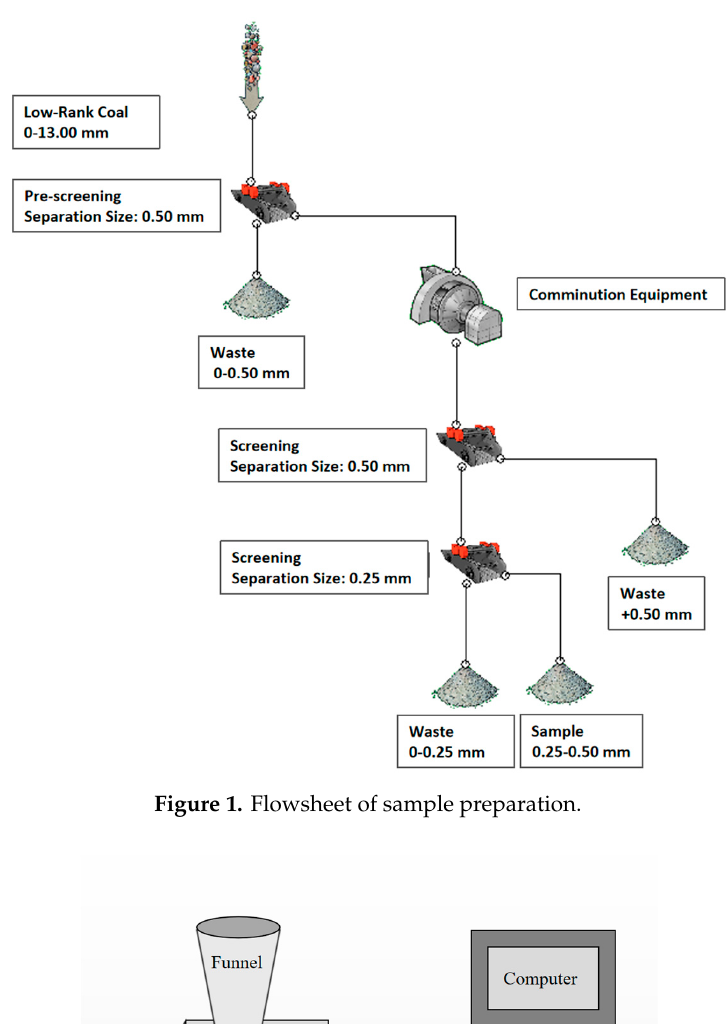
Figure 1. Flowsheet of sample preparation. Figure 1 . Flowsheet of sample preparation.